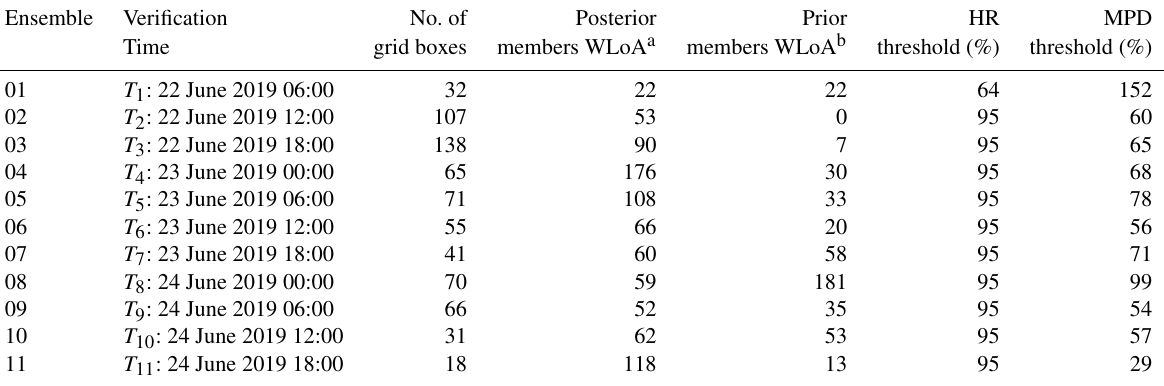
Table 2. Number of members within limits of acceptability (WLoA), and HR and MPD thresholds for each ensemble at each verification time.